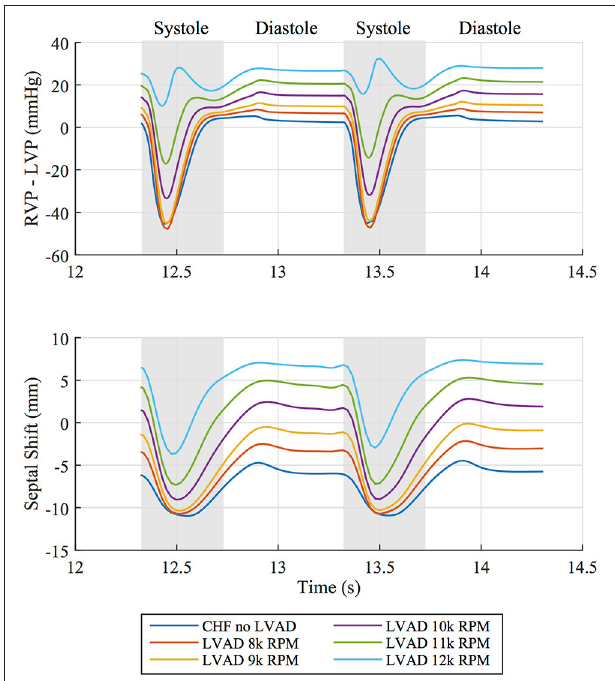
FIGURE 6 | (Top) Pressure difference between right ventricular pressure (RVP) and left ventricular pressure (LVP) over two cardiac cycles for all simulated cases. (Bottom) Corresponding leftward septal shift over the same time period. Diastolic and systolic portions of the cardiac cycle are